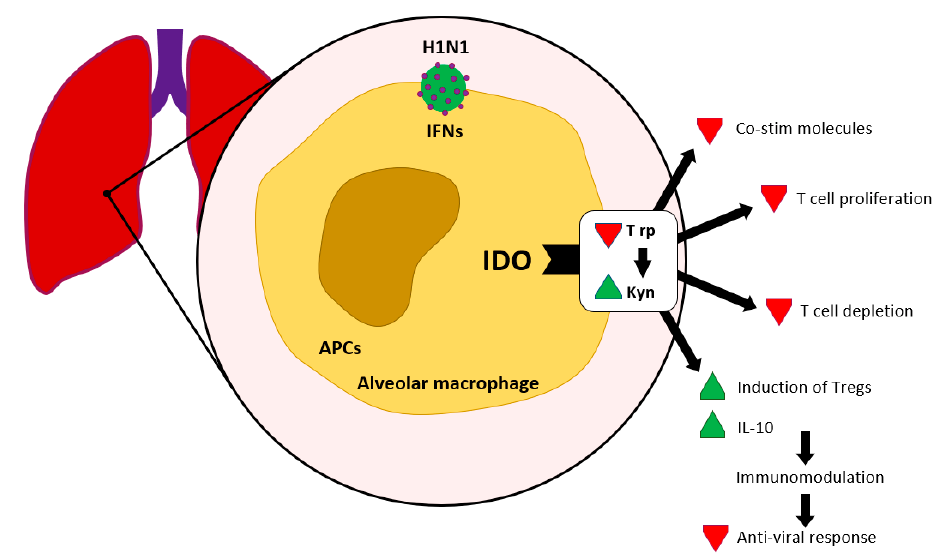
Figure 3. IDO in viral infections according to [11]. Interferon contributes to the activation of IDO, which leads to Kyn production and Trp depletion.